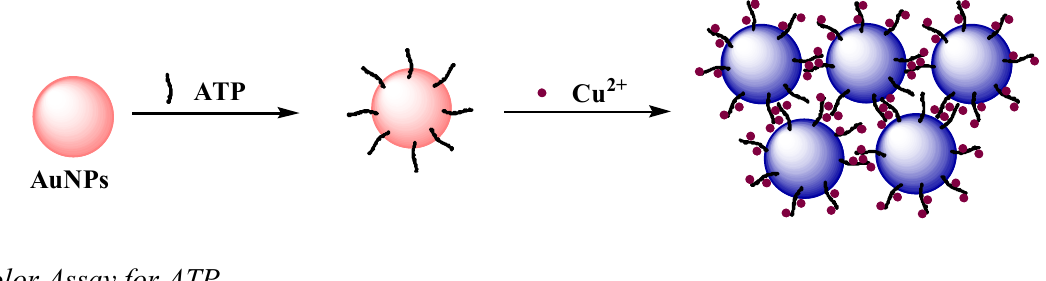
Figure 1. Schematic illustration of the strategy of ATP detection using AuNPs as indicators and Cu 2+ ions as cross-linkers.